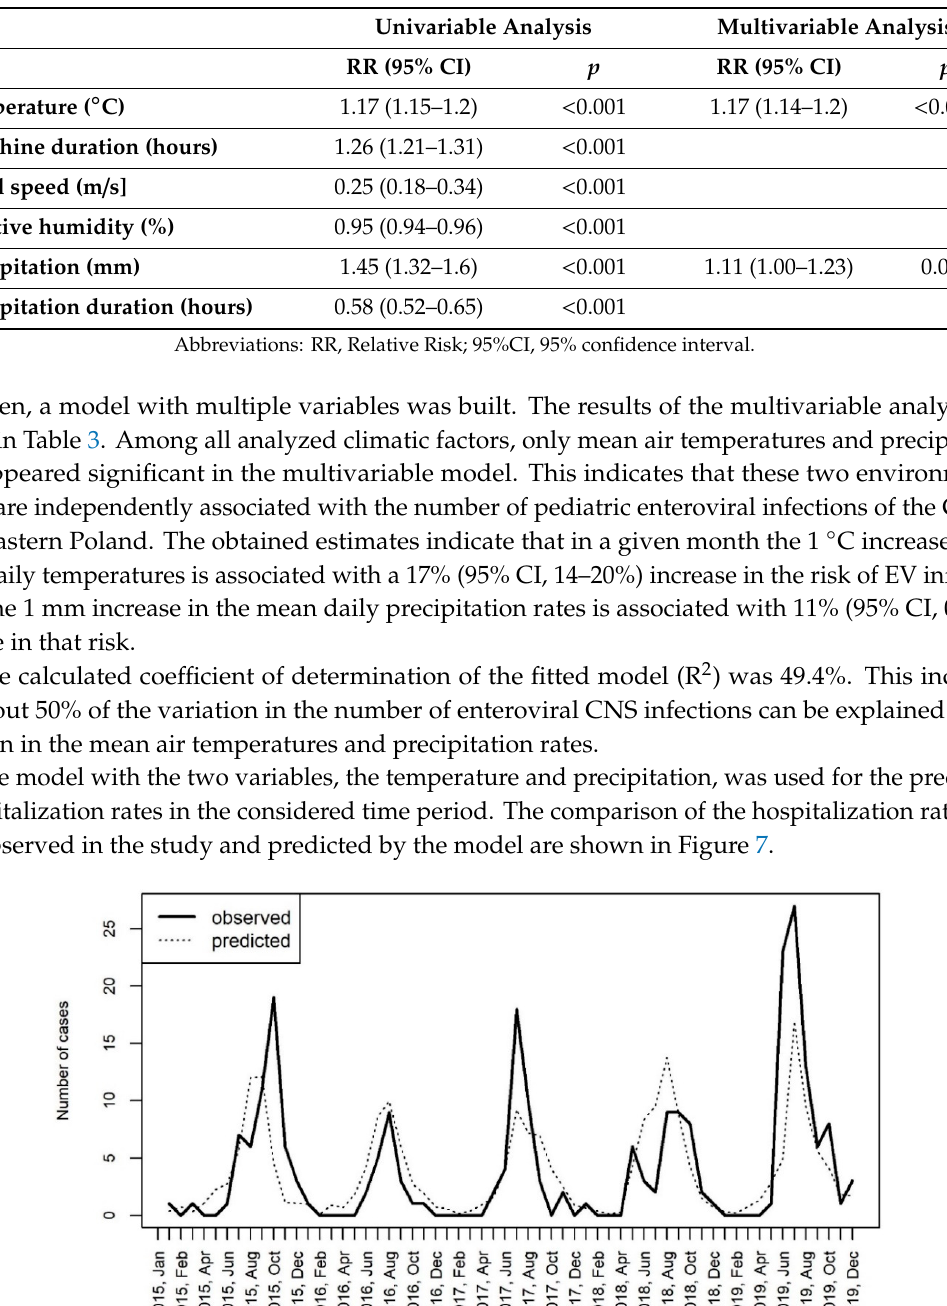
Table 3. Predictive factors of the number of cases of pediatric enteroviral infections of the CNS by uni- and multivariable generalized linear mixed models (GLMM). The coe ffi cient of determination (R 2 ) of the multivariable model was 49.4%.